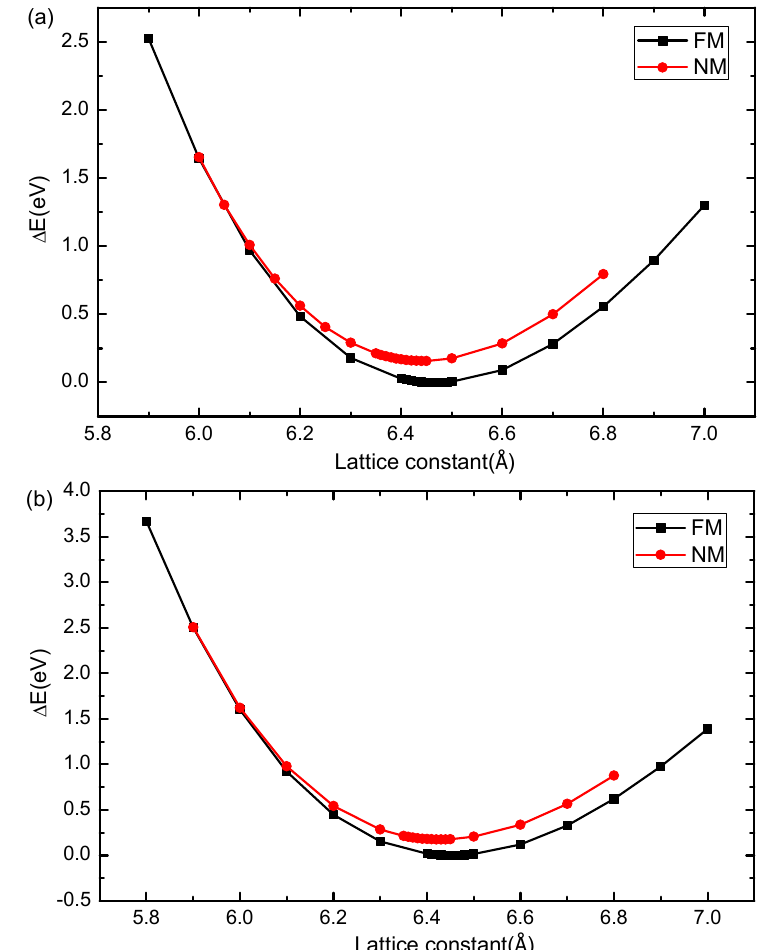
Figure 2. Total energy as a function of the lattice constant in the non-ferromagnetic (NM) and ferromagnetic (FM) states for ZrRhTiAl ( a ) and ZrRhTiGa ( b ) compounds. The lowest energy in the FM state is set as zero point.